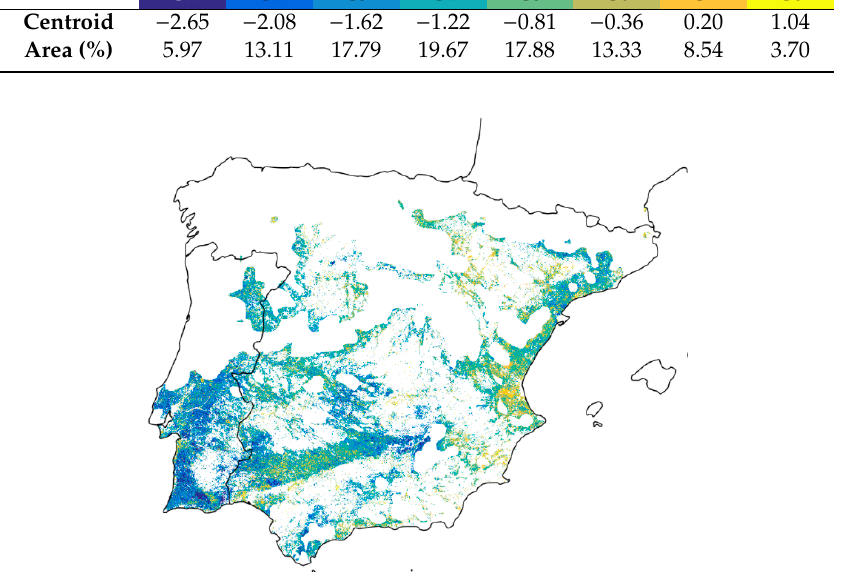
Figure 4. Spatial distribution of the 8 clusters obtained using NDVI std . Color code for NDVI std clusters is shown in Table 3.